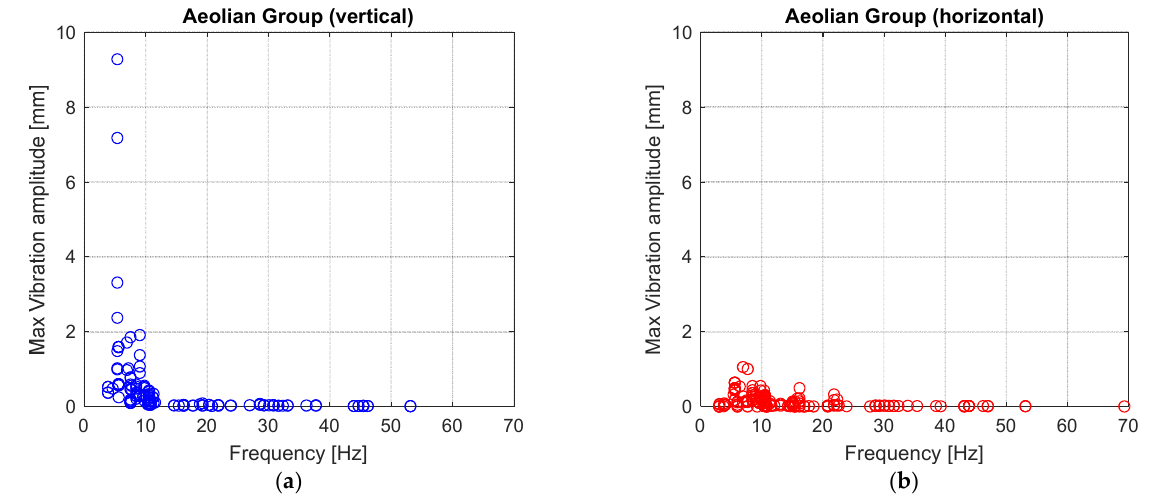
Figure 18. ( a ) Maximum vertical vibration amplitude and ( b ) maximum horizontal vibration ampli- tudes versus vibration frequency for “Aeolian” group.